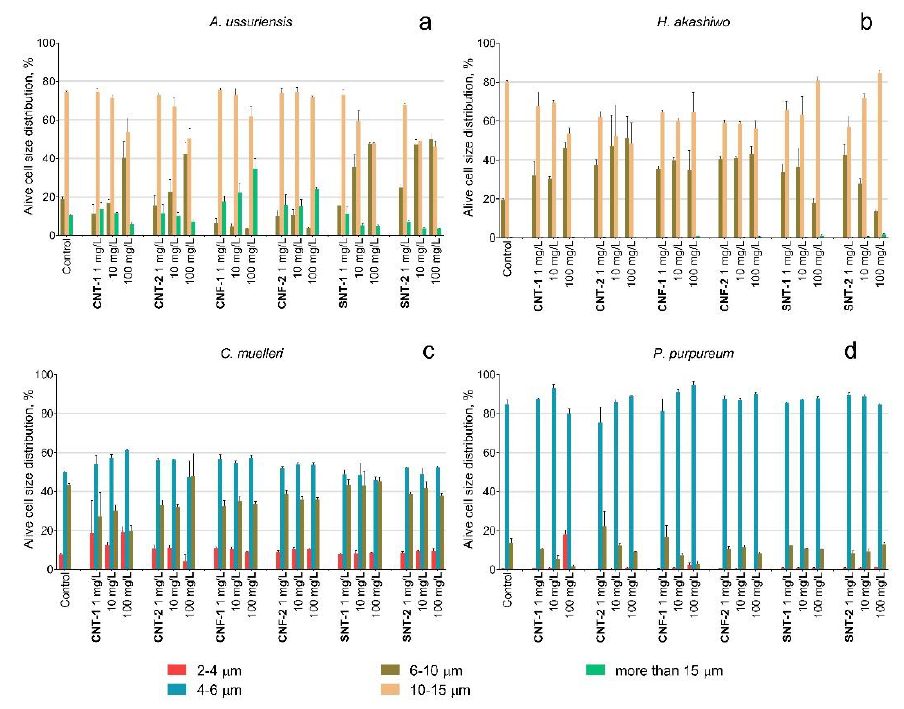
Figure 2. The changes of size distribution of microalgae cells after 96 h of exposure to NPs: ( a ) A. ussuriensis ; ( b ) H. akashiwo ; ( c ) C. muelleri ; ( d ) P. purpureum .